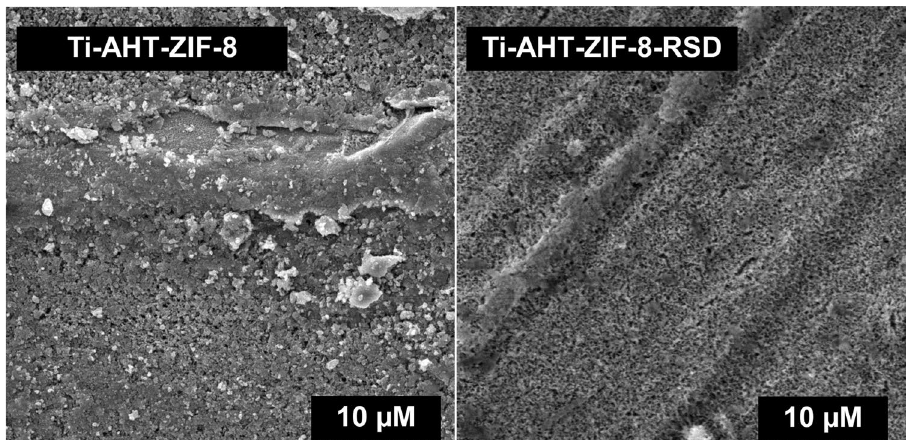
Figure 2. SEM images of Ti-AHT-ZIF-8 and